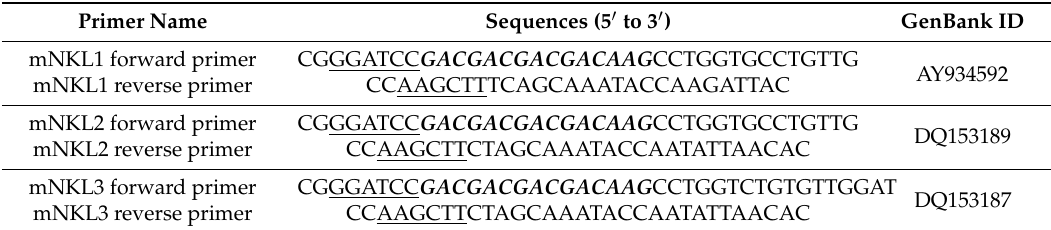
Table 1. Primers and their sequences used in this